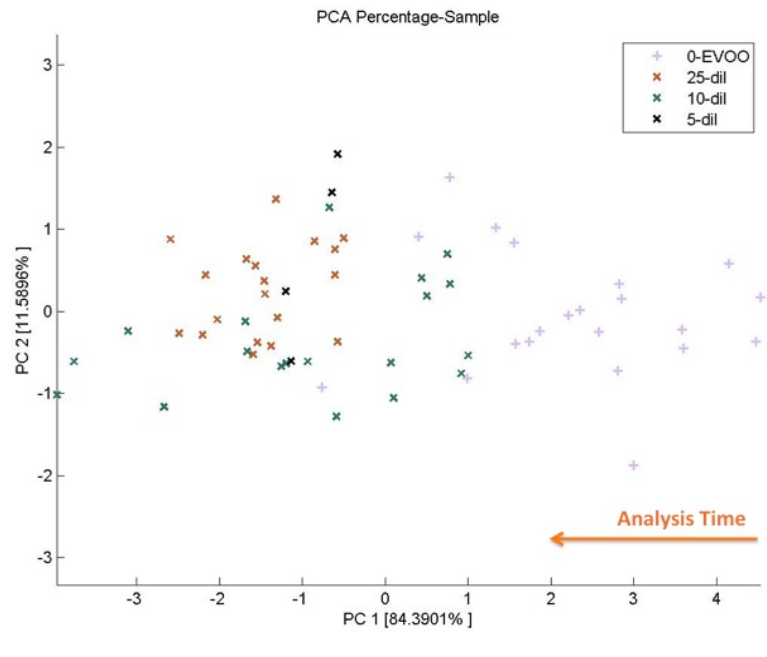
Figure 13. PCA score plot of data related to pure EVOO and HD-EVOO samples (5 to 25% V/V). Reprinted from [47] with permission from AIP, Copyright